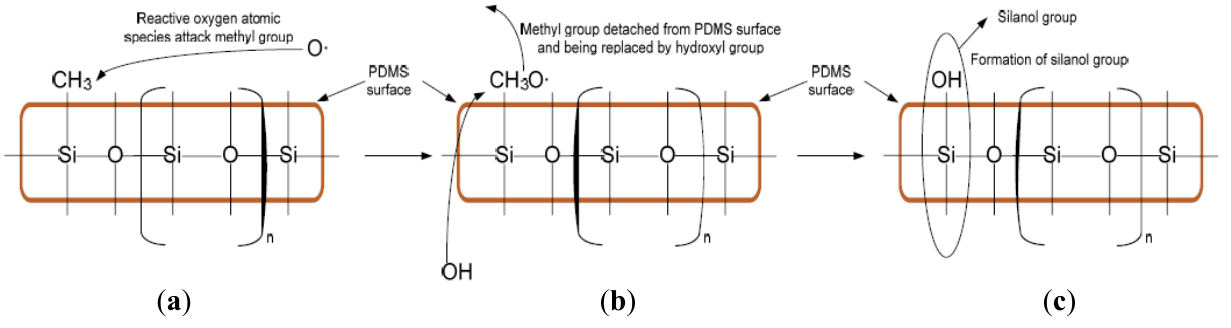
Figure 1. Methyl group in a Polydimethyl Siloxane (PDMS) network replaced by a Silanol group. ( a ) Methyl group being attacked by the reactive atomic oxygen species, generated in Piranha Solution. CH O – intermediate is formed ( b ) Unstable CH 3